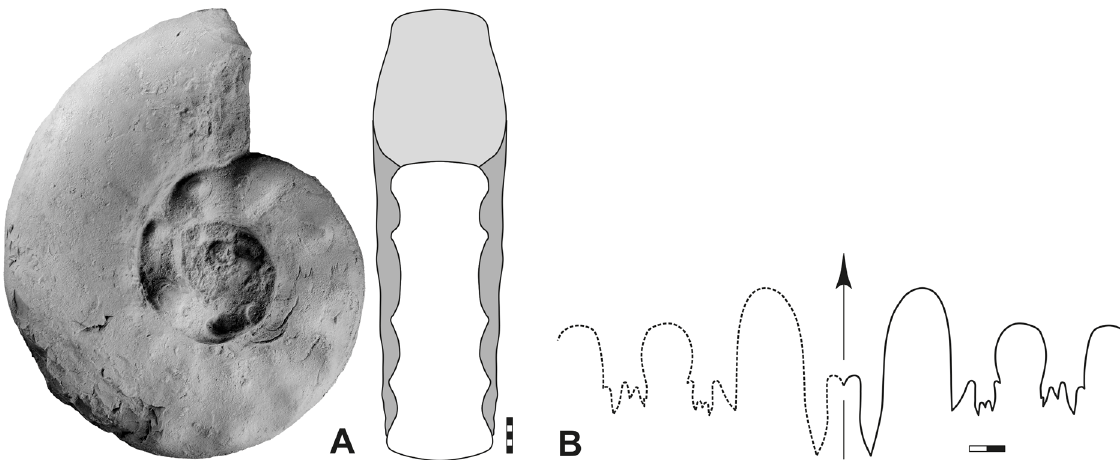
Fig. 50. Lutites paucis Korn & Hairapetian gen. et sp. nov. A . Lateral and dorsal view, holotype MB.C.29991, section C, -2.45 m. B . Suture line, holotype MB.C.29991, at 13.7 mm wh.